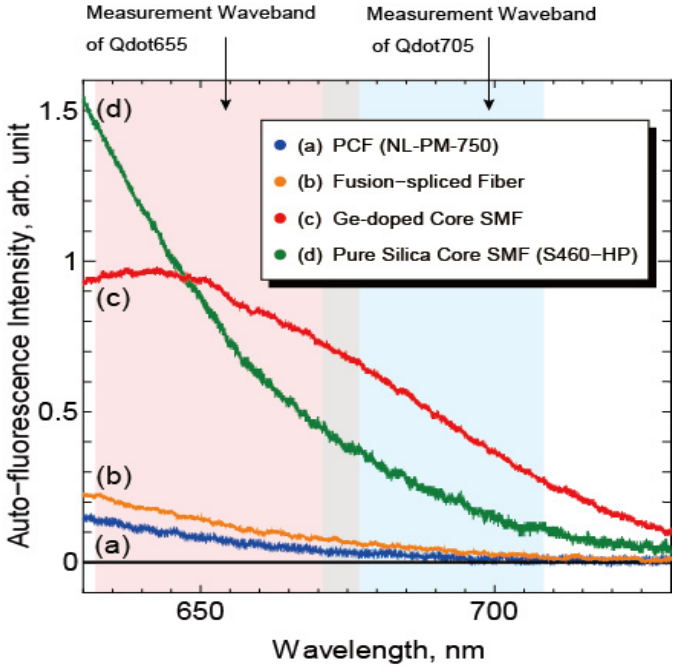
Figure 6. Auto-fluorescence spectra of (a) PCF (NL-PM-750, NKT Photonics Co.), (b) The fabricated fusion-spliced near-field optical fiber, (c) Ge-doped core SMF (JASCO Co.), and (d) Pure silica core and F-doped cladding SMF (S460-HP, Nufern Co.). The auto-fluorescence intensity of PCF is remarkably small compared to that of the conventional SMFs. In the case of the fusion-spliced fiber, an increase in auto-fluorescence caused by the spliced SMF was observed; however, the auto-fluorescence intensity was still much smaller than that of